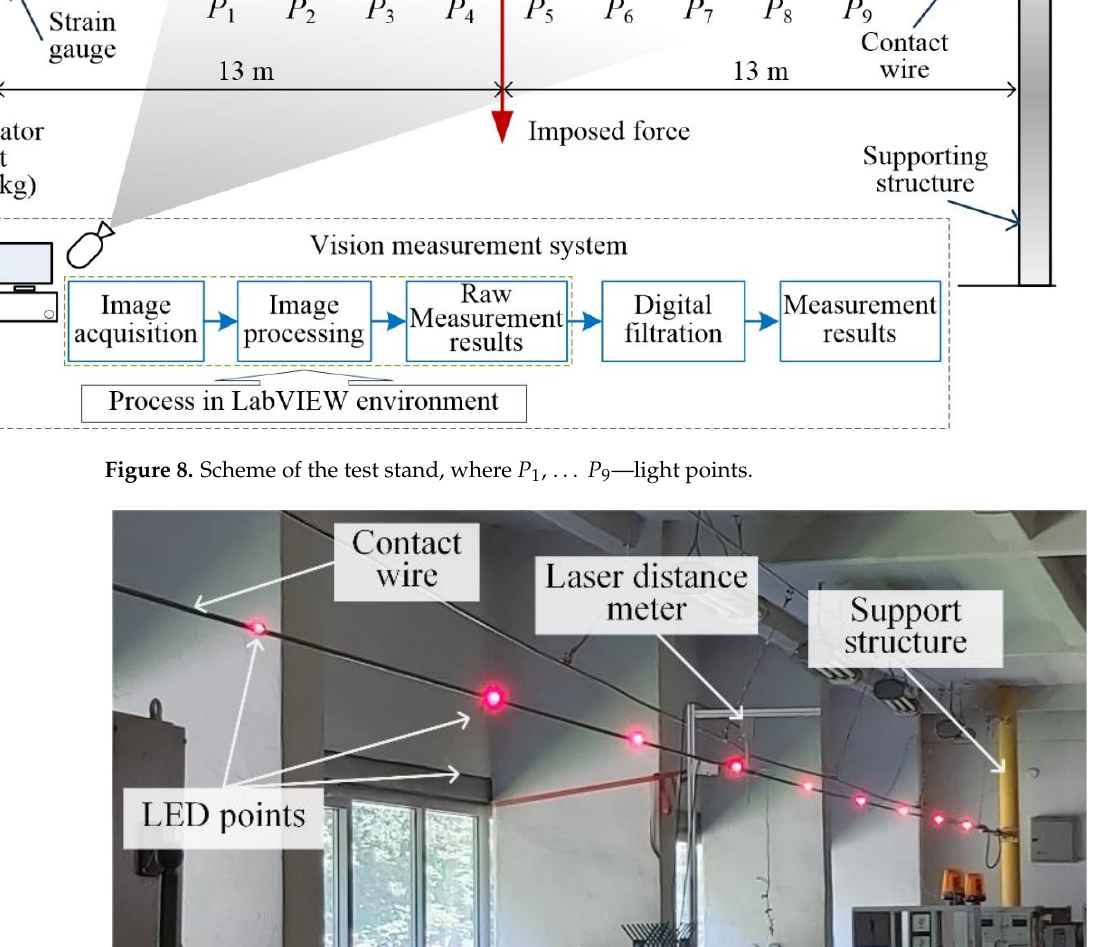
Figure 9. Contact wire with mounted LED points.